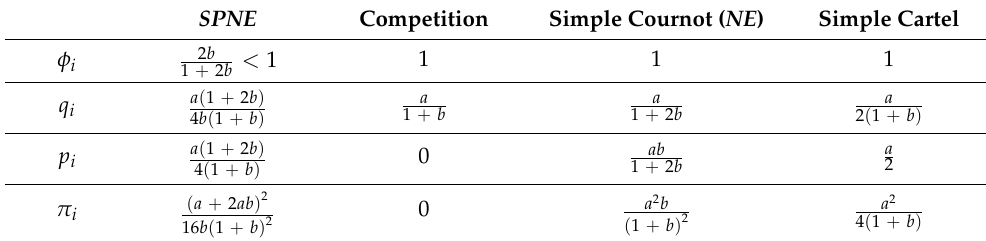
Table 1. Equilibrium Values when Firms Compete in Output.